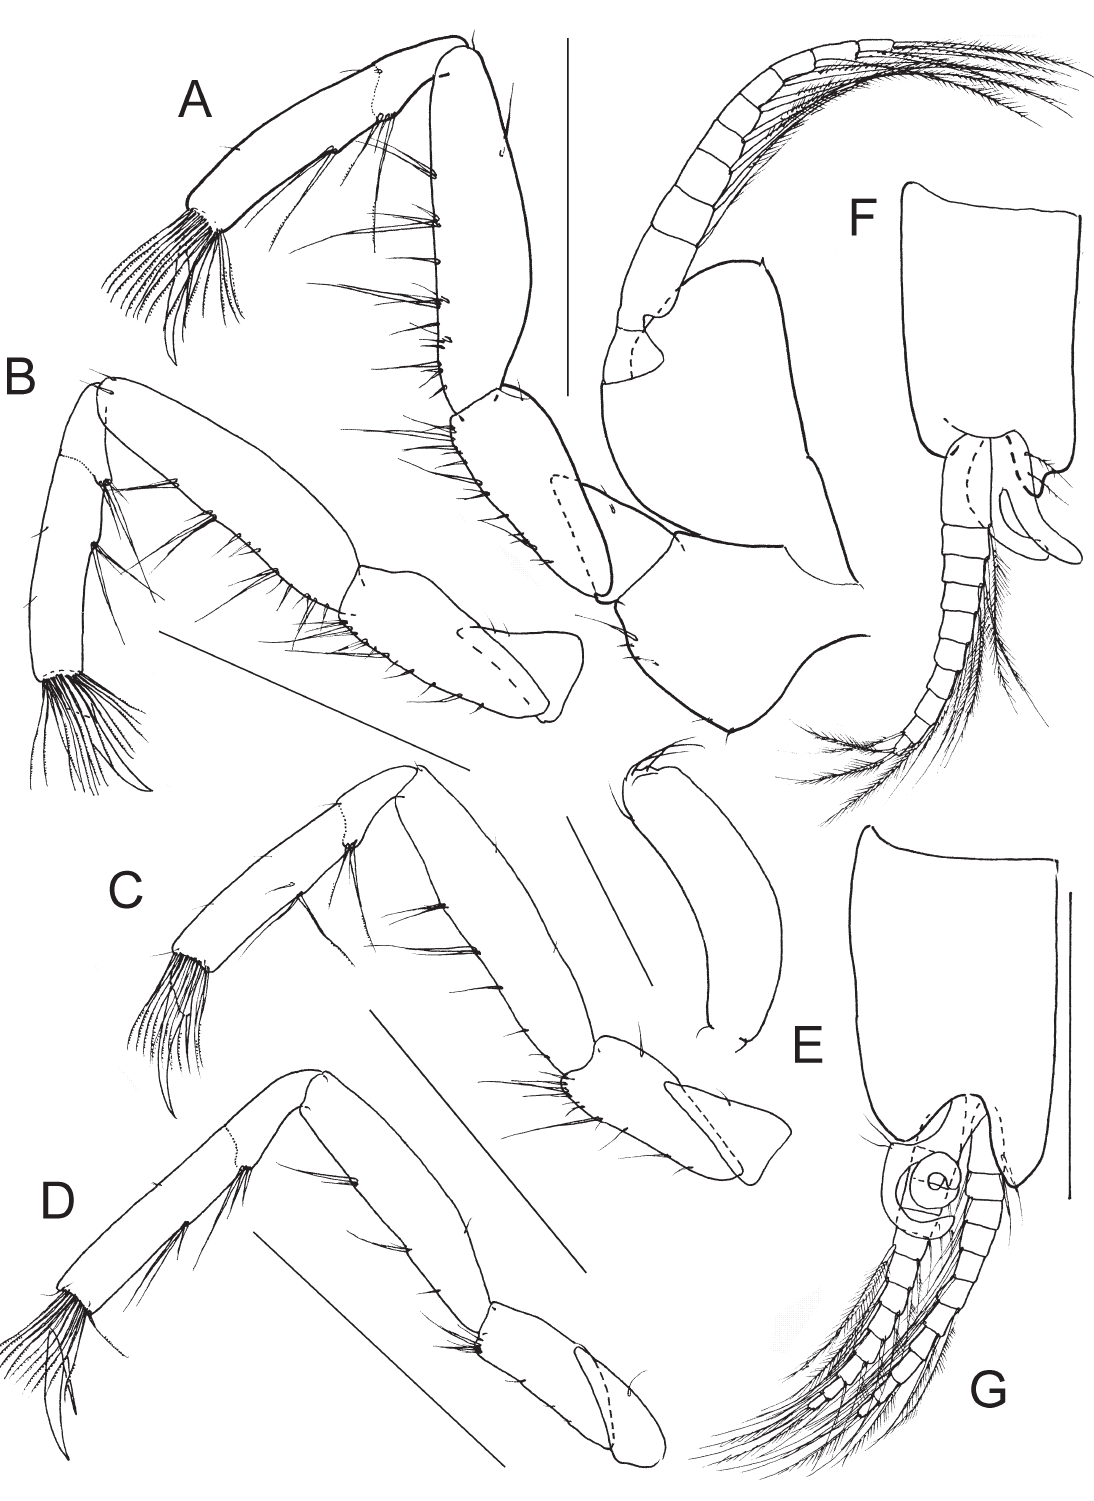
Fig. 13. Siriella hanseni W.M. Tattersall, 1922, Laccadive Sea, Gulf of Manaar, India. A . Pereopod 2, anterior view. B . Endopod of pereopod 3, anterior view. C . Endopod of pereopod 5, anterior view. D . Endopod of pereopod 6, anterior view. E . Penis. F . Pleopod 1, anterior view. G . Pleopod 4, posterior view. A–C, E–G = lectotype, ♂, length 5.5 mm; D = paralectotype, ♂, length 5.5 mm. Scale bars: A–D, F–G = 0.5 mm; E = 0.25